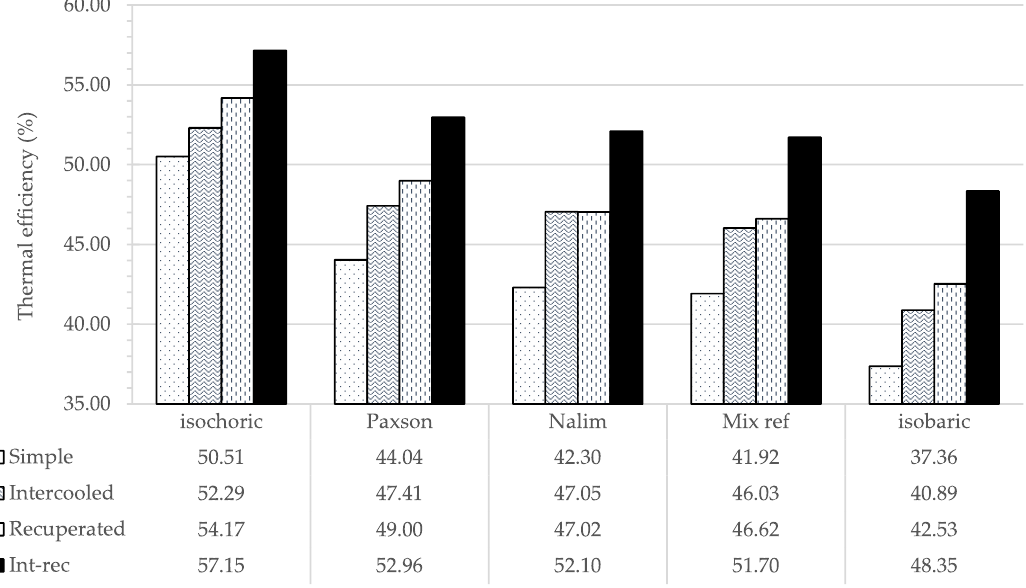
Figure 4. Thermal efficiency for various models and cycles at T mat of